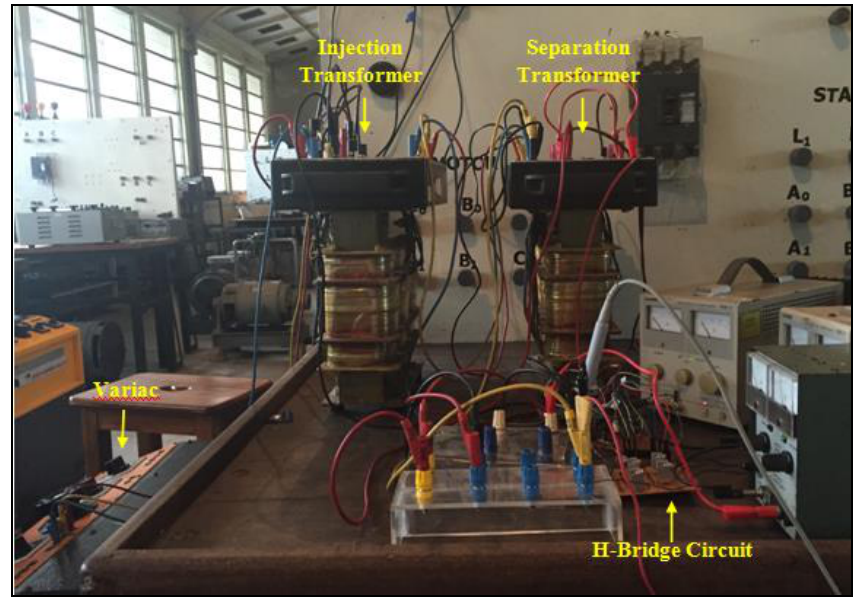
Figure 11: Laboratory setup.